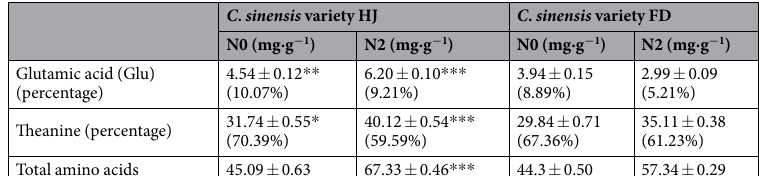
Table 3. The amino acid content in Camellia leaves before and after ammonium treatment. The above table shows the content of amino acids in the tea leaves of HJ and FD. N0 represents the control of C . sinensis HJ/FD, and N2 represents the C . sinensis HJ/FD treated with (NH 4 ) 2 SO 4 . The percentage is the amount of amino acids relative to total amino acids. * , ** , and *** represent statistical t-test P values less than significance levels 0.05, 0.01, and 0.001, respectively, in the HJ variety compared to the FD variety at the same N